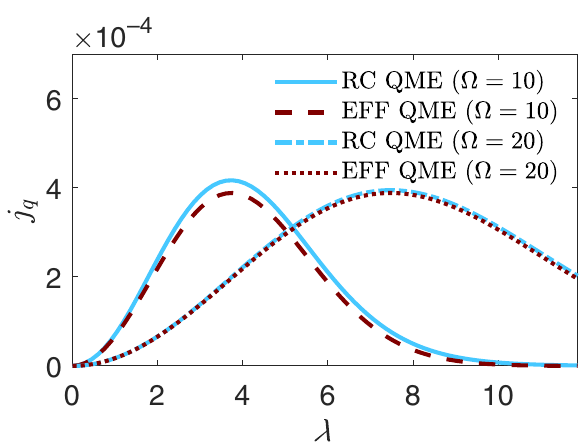
FIG. 6. Quantum heat transport in the nonequilibrium spin- boson model. We present the steady-state heat current computed with the RC-QME method (cyan) and the EFF-QME technique (maroon) at two different RC frequencies, (cid:5) = 10 and (cid:5) = 20. The parameters are (cid:11) = 1, T h = (cid:11) , T c = (cid:11)/ 2, γ = 0.0071, and (cid:10) =